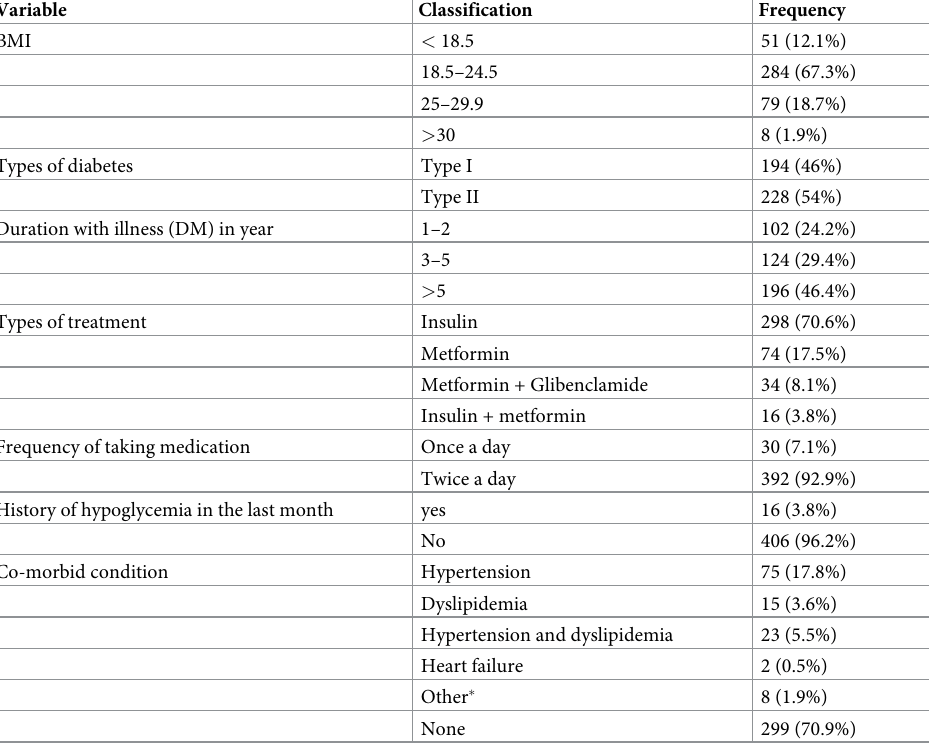
Table 2. Clinical characteristics of the study participants, UoGRTH, Northwest-Ethiopia, 2019 (N = 422). Variable